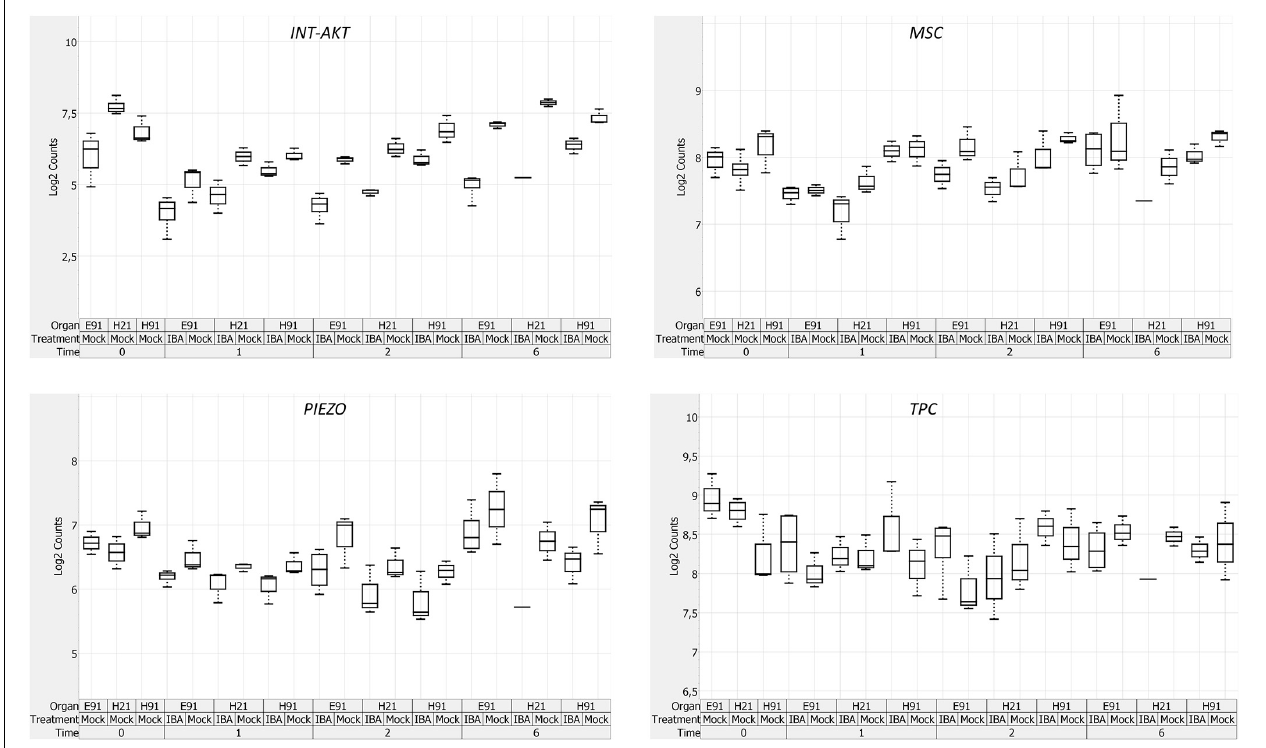
FIGURE 5 | Expression profile of genes encoding ion channels in rooting-competent hypocotyl cuttings from 21-day-old seedlings (H21) and both non-competent hypocotyl (H91) and epicotyl (E91) cuttings from 91-day-old-seedlings at the time of excision (t0) and during adventitious root formation. RNA was extracted from the bases of hypocotyl (H) and epicotyl (E) cuttings treated with 10 µ M indole-3-butyric-acid at the indicated times (days). Hypocotyl and epicotyl cuttings maintained in water were used as controls (mock). A box plot analysis was performed on the basis of the NanoString results. The bottom and top of each box indicates the 25th and 75th percentile of data expression values, respectively, the band in the middle of the box indicates the median expression value, and the ends of the whiskers indicate the minimum and maximum values. Expression values for the box-plot analysis were log2